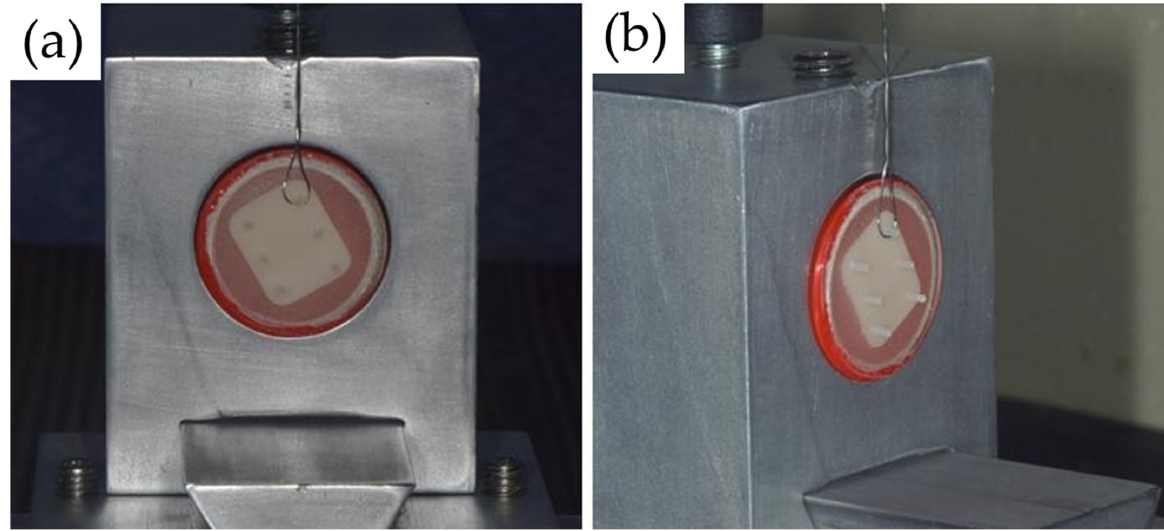
Figure 3. ( a ) Front view of the µSBS test; ( b ) isometric view of the µSBS test.